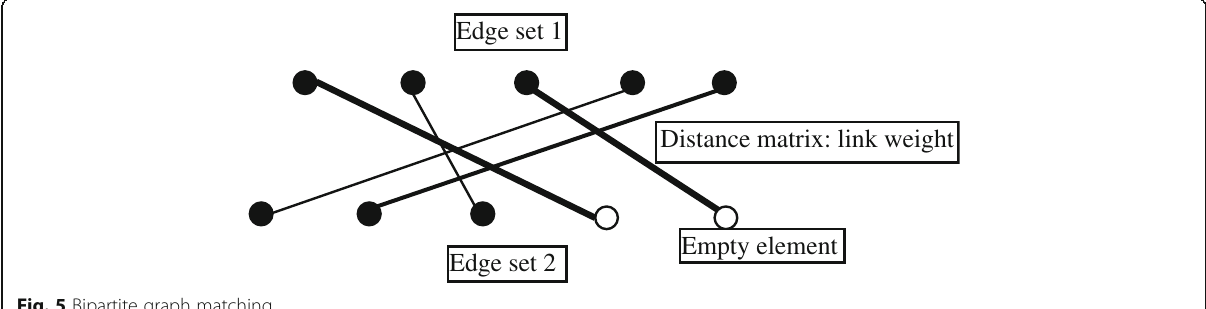
Fig. 5 Bipartite graph matching